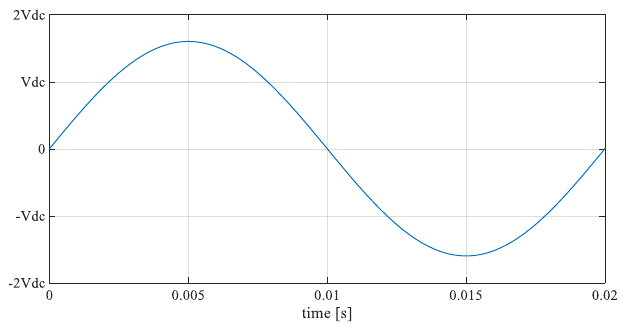
Figure 3. Sinusoidal modulating signal.